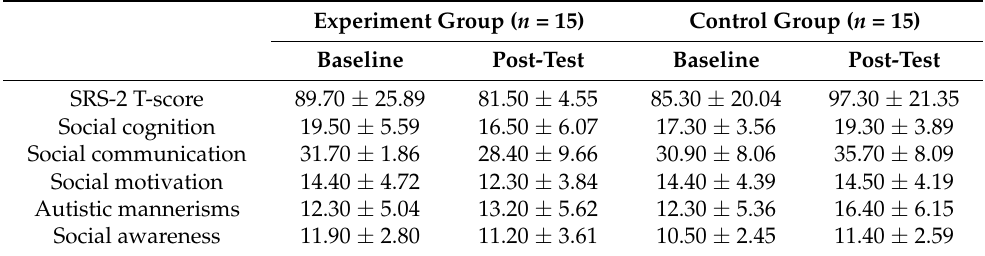
Table 3. Analysis of two groups for social communication variables (M ±